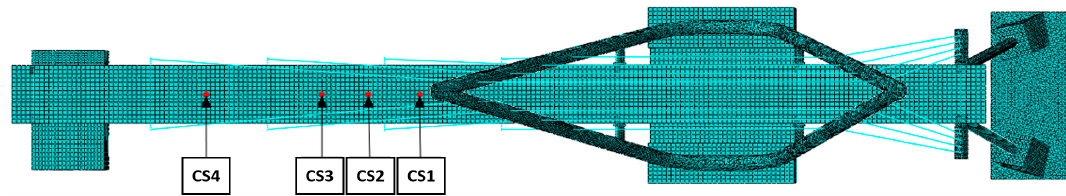
Figure 10. Location of points on the deck of the cable-stayed footbridge selected for the analysis of dynamic performance under human movement: CS1, CS2, CS3, and CS4.